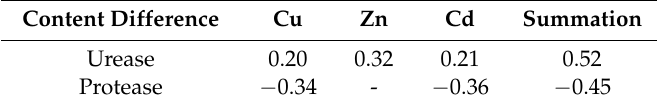
Table 6. Pearson correlation of enzymes and heavy metals in